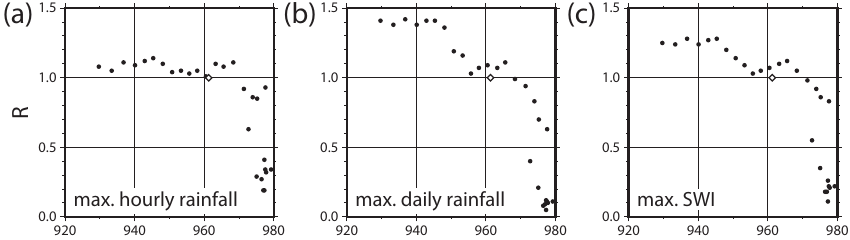
Figure 9. Relationship between the minimum central sea-level pressure of the typhoon ( x axis [units: hPa]) and R ( y axis) for (a) the maximum hourly rainfall amount, (b) the maximum daily rainfall amount, and (c) the maximum